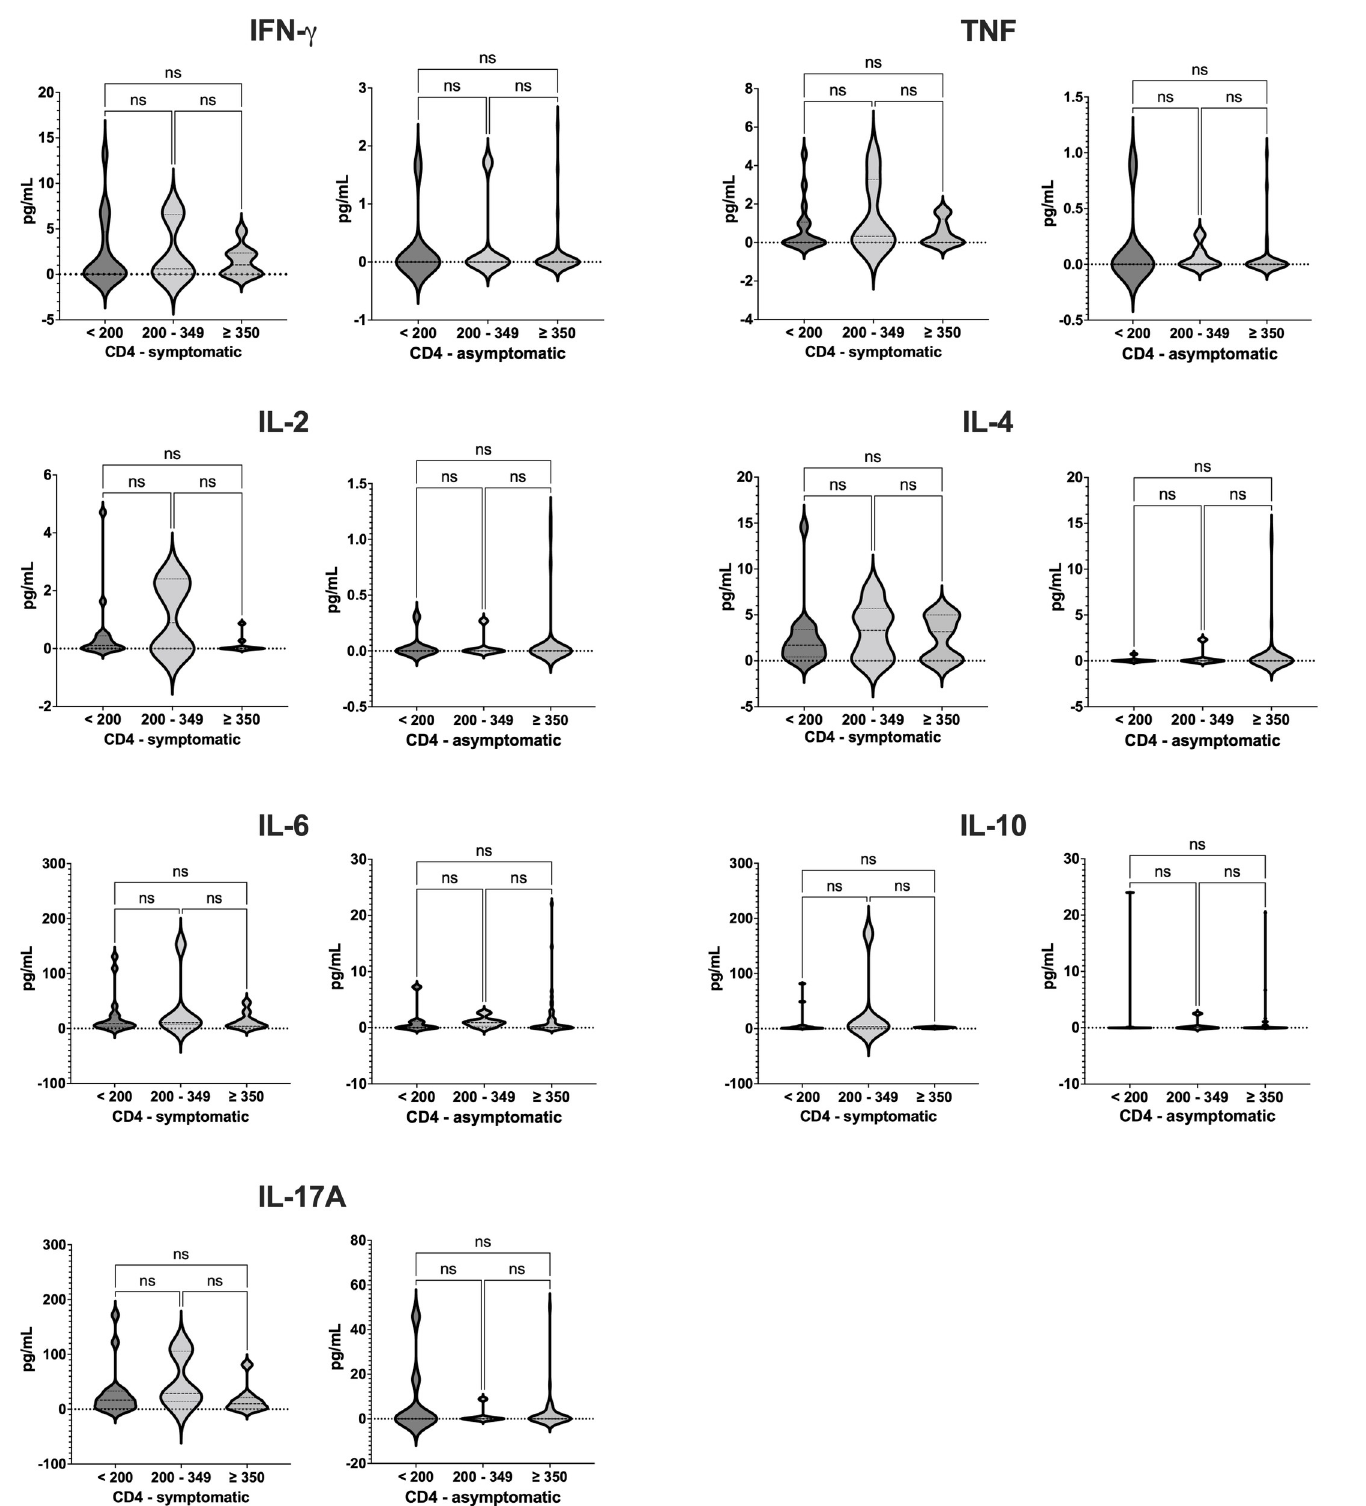
Fig 2. Serum cytokine levels by CD4 count, by disease group (asymptomatic and symptomatic VL-HIV coinfected individuals). ns, not significant.